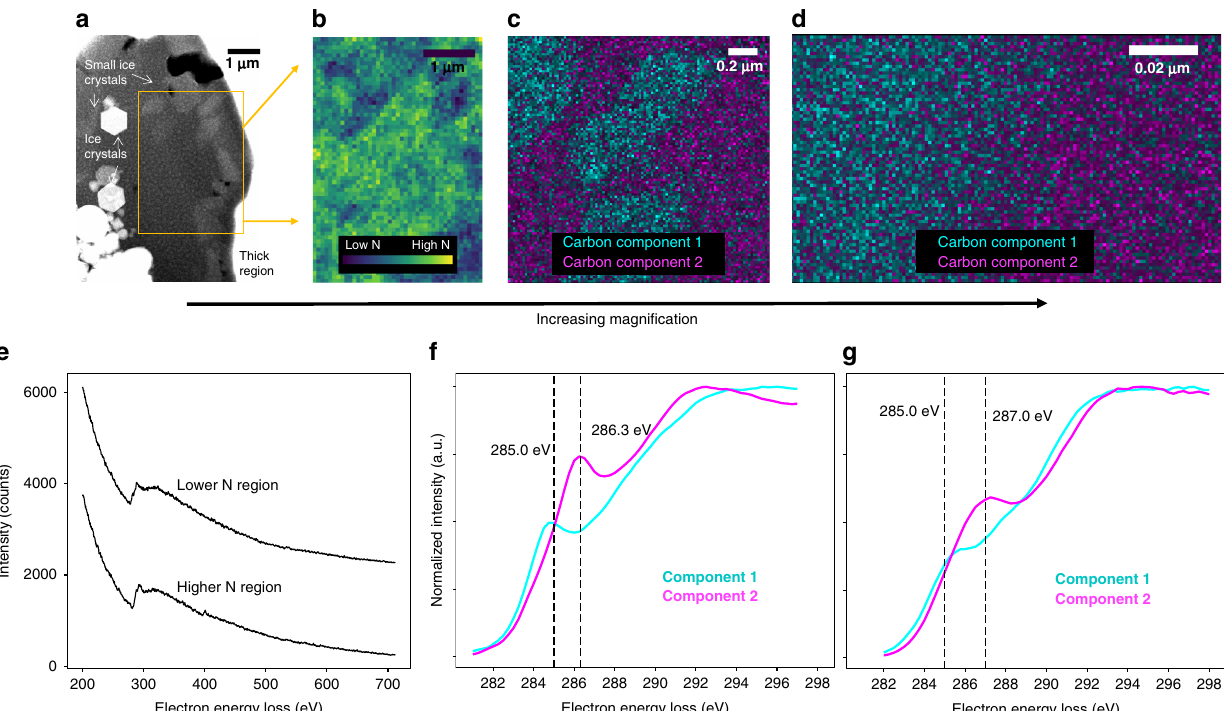
Fig. 3 Composition of organic features and the organo – organic interface. High-resolution imaging and spectroscopy of organo – organic features and their interface by cryo-scanning transmission electron microscopy and electron energy-loss spectroscopy (cryo-STEM-EELS). a Overview low-magni fi cation (5 kx) annular dark- fi eld (ADF) STEM image of cryo-focused ion beam (cryo-FIB) thin section of organic-rich volcanic soil. The approximate region indicated by a box was used for subsequent electron energy-loss spectroscopy (EELS) mapping of carbon (C) and nitrogen (N). b EELS elemental map showing the patchy distribution of low-N features in the high-N matrix. c Patchy distribution of organic matter (OM) features micrometers in size, shown with EELS maps of the two distinct carbon (C) bonding environments, as revealed by carbon K-edge multivariate curve resolution (MCR) component fi ts (component spectra are shown in f ). d Nanometer-scale EELS C K-edge MCR component map of the interface between two OM patches (component spectra shown in g ). For c , d , the cyan color channel contrast and brightness were auto-adjusted in ImageJ 71 . e Raw EELS data for representative lower N (top spectrum) and higher N (bottom spectrum) regions in ( b ). Spectra show the high C K-edge (~280.0 eV) intensity relative to N (~400.0 eV) and O (~530.0eV) intensities. f , g Normalized (maximum = 1) C K-edge MCR component spectra corresponding to ( c , d ), with a distinctive transition from ~285.0 eV in component 1 (assigned to aromatic C = C bonds) to higher-energy features (~286.3 – 287.0 eV) in component 2. Features in spectra are shown by dotted vertical lines. Spectra are shown as raw (unsmoothed) MCR fi t outputs normalized to the maximum output